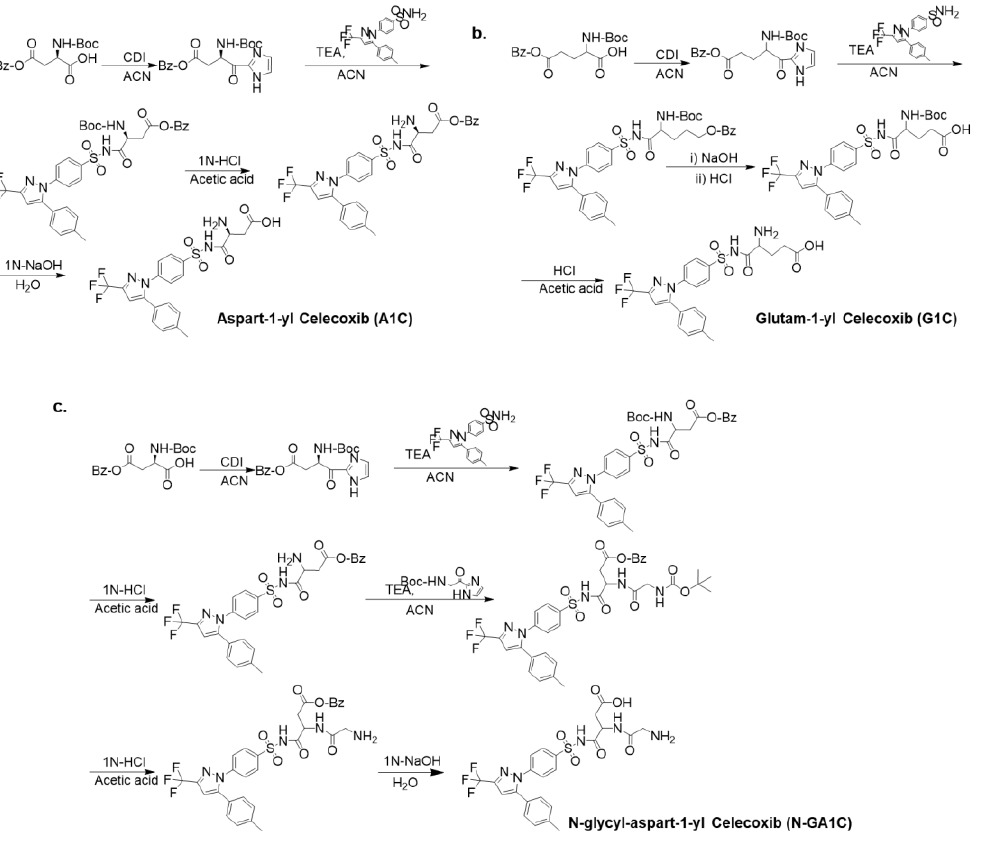
Scheme 1. Synthesis scheme of aspart-1-yl celecoxib (A1C, a ), glutam-1-yl celecoxib, (G1C, b ), and N -glycyl-aspart-1-yl celecoxib (N-GA1C, c ). Adapted from [9,10], published by Springer Nature, 2012 and Dovepress, 2015. Table 1. IR spectra, NMR spectra, elemental analysis, log D 6.8 values and melting point (MP) of celecoxib, A1C, G1C, and N-GA1C.